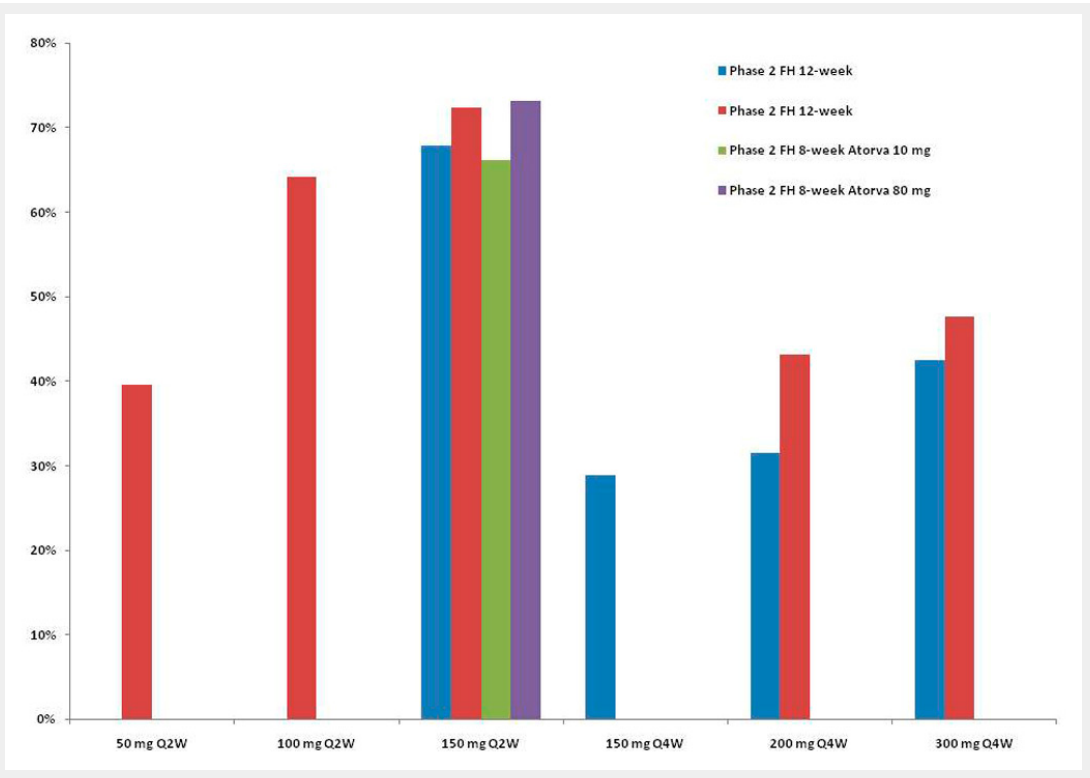
Figure 3 Mean percent decrease from baseline in low-density lipoprotein (LDL) cholesterol levels with the SAR236553/REGN727 regimen. Results were derived from